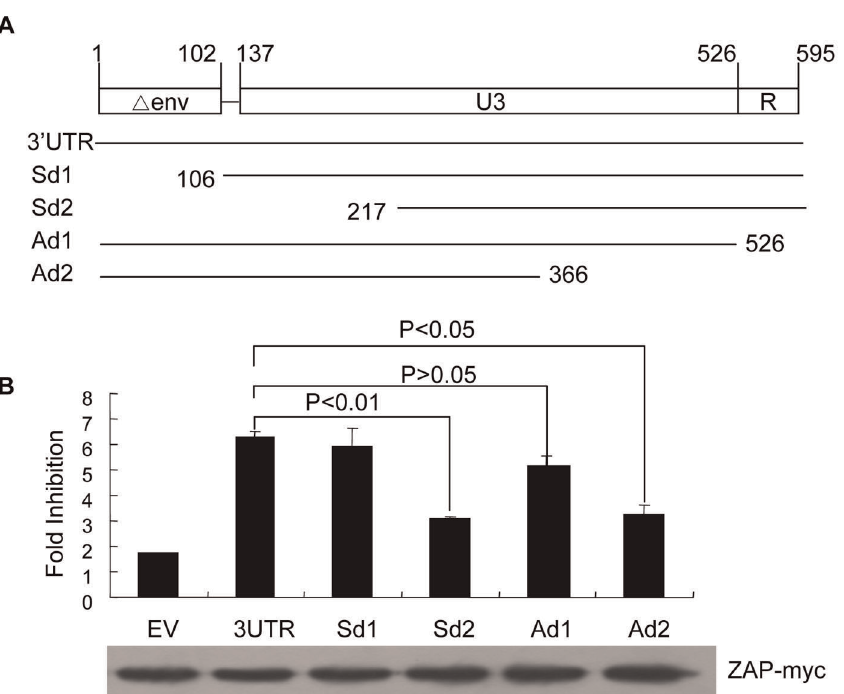
Figure 6. Mapping of ZRE in the 3 9 LTR of XMRV. (A) Schematic structures of the truncation constructs of 3 9 UTR. (B) Analysis of the sensitivity of the 3 9 UTR truncation mutants to ZAP. Fold inhibition was measured as described in the legend to Figure 5B. Data presented are means 6 SD of three independent experiments.